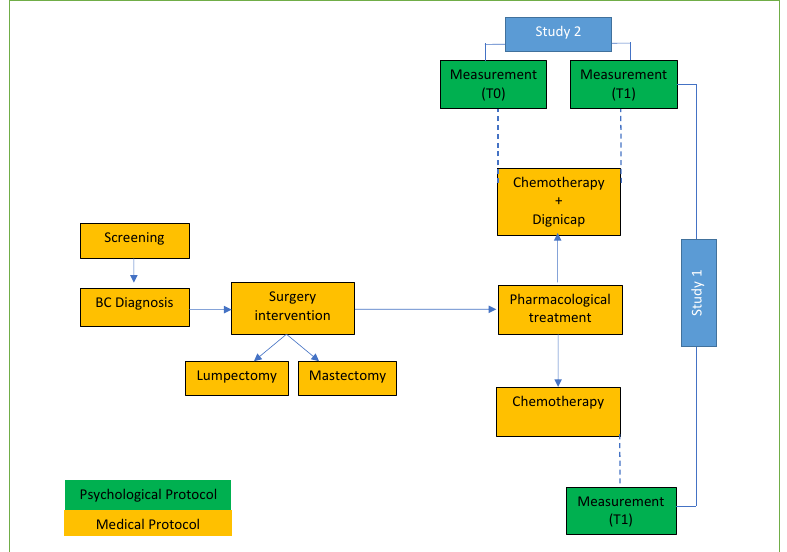
Figure 1. Study Protocol.